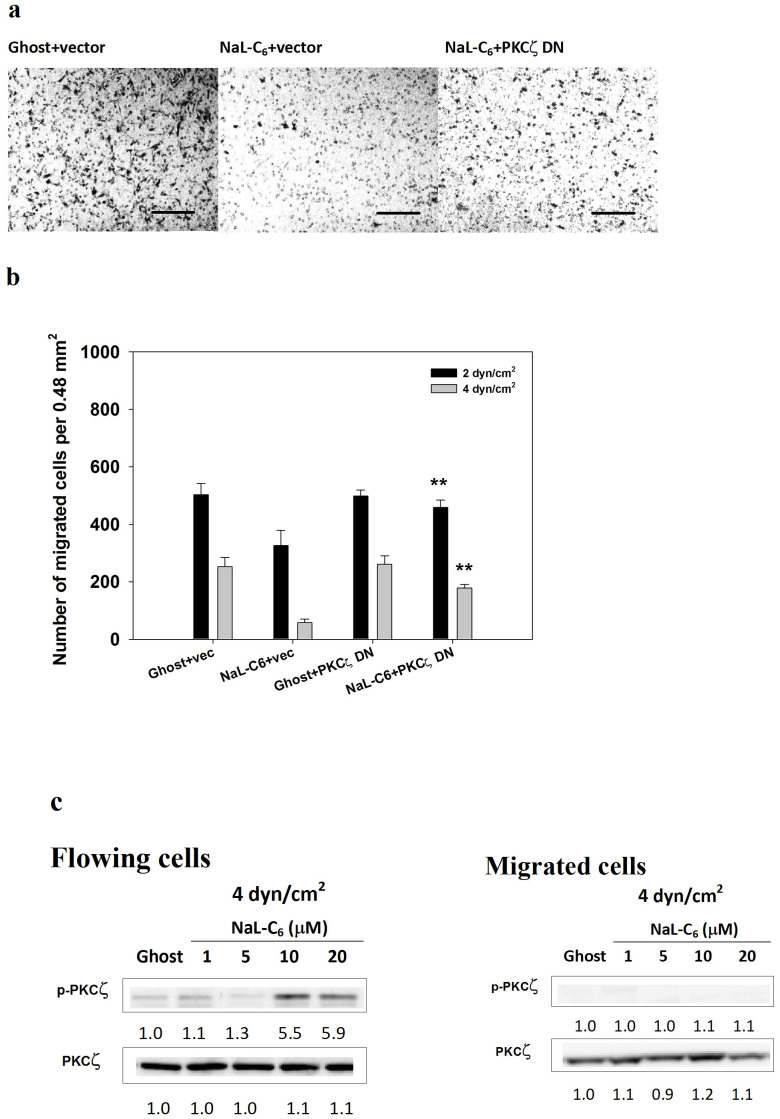
NaL-C6 suppressed tumor extravasation under flow conditions in a way that required PKCζ activation.(a) PKCζ DN partially restored the migratory potency of MDA-MB-231 cells which was suppressed by NaL-C6 as shown by images of transmigrated cells at the bottom of the filter. After 4-hr flow migration experiments at a shear stress of 4 dyn/cm2, chambers were dissembled and filters were stained. Images were taken from 10× objective. Ghost+vector: cells were transfected with empty vector and treated with ghost nanoliposomes; NaL-C6+vector: cells were transfected with empty vector and treated with C6-ceramide nanoliposomes; NaL-C6+ PKCζ DN: cells were transfected with PKCζ DN constructs and treated with C6-ceramide nanoliposomes. (b) PKCζ DN rescued NaL-C6-suppressed MDA-MB-231 migration at a shear stress of 2 or 4 dyn/cm2. Vector or PKCζ DN-transfected MDA-MB-231 cells were treated with ghost or 20 μM C6-ceramide nanoliposomes for 30 min. Then, cells were introduced into flow migration chamber together with 1.5 mg/ml fibrinogen. The number of cells migrated after 4 hr assay was measured. Results were expressed as mean ± SEM. n = three replicates.*p < 0.05 compared with NaL-C6+vector.(c) The lack of migratory potency of MDA-MB-231 cells was correlated with phosphorylation of PKCζ. MDA-MB-231 cells were treated with various doses of C6-ceramide nanoliposomes or ghost nanoliposomes for 30 min prior to flow migration experiments. After flow migration at 4 dyn/cm2 for 4 hr, flowing cells were collected from the circulation loop and migrated cells were trypsinzed. Flowing and migrated cells were subjected to western blotting analysis of phospho-PKCζ and total PKCζ. Data represent three replicates.